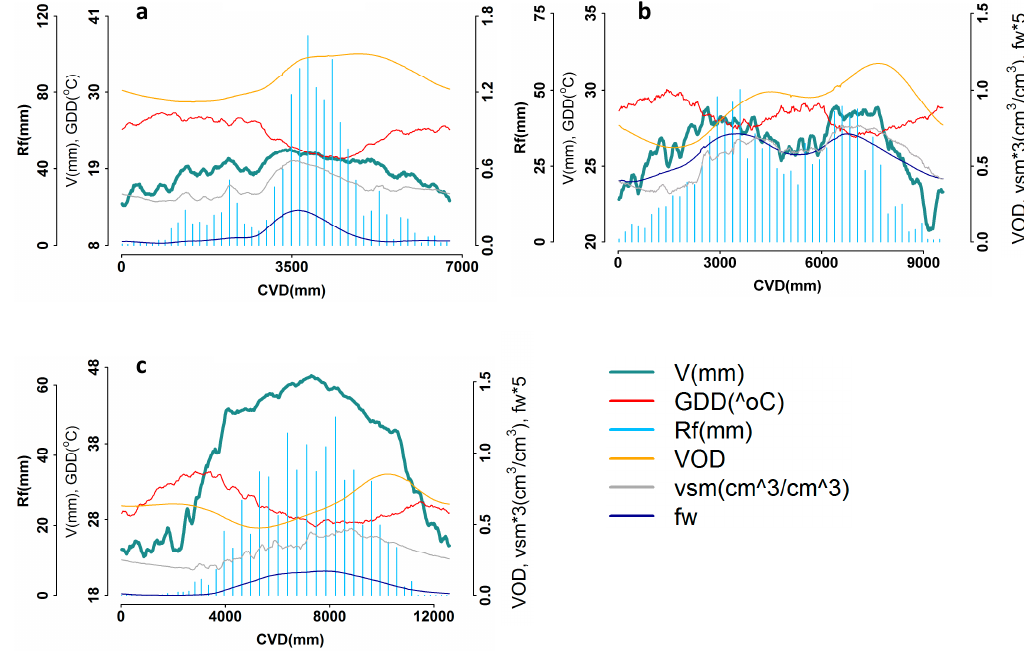
Figure 6. Line graphs and bars of multiyear average (2003–2015) of AMSR V, GDD, vsm, fw, and VOD (10.65 GHz) with TRMM rainfall (Rf) as a function of cumulative vapor days (CVDs) for an AMSR pixel at sites in Ethiopia (( a ) #73), South Sudan (( b ) #78), and Tanzania (( c ) #14). Note differences in scaling of axes.